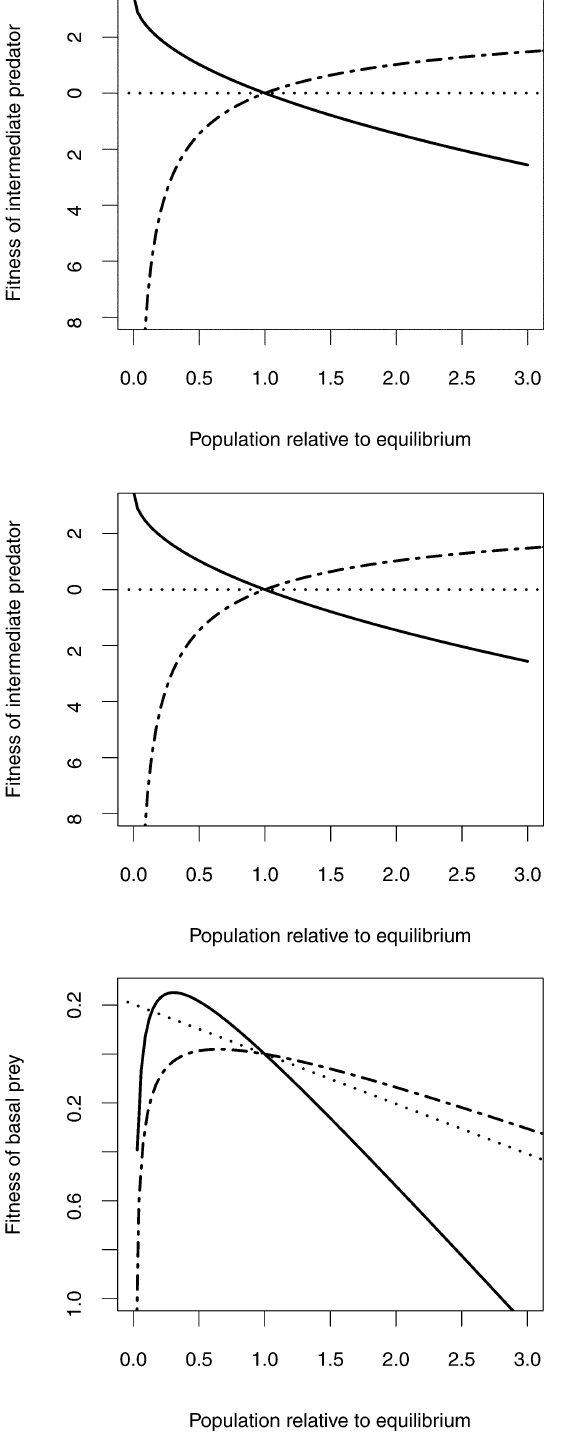
Fig. 2. Inter- and intra-specific effects of each species on other species. Top predators (solid line), intermediate predators (dotted line), basal prey (dashed line). r = 1, K = 1, A 0.5, m = 0.5, b = 3, b = P P N